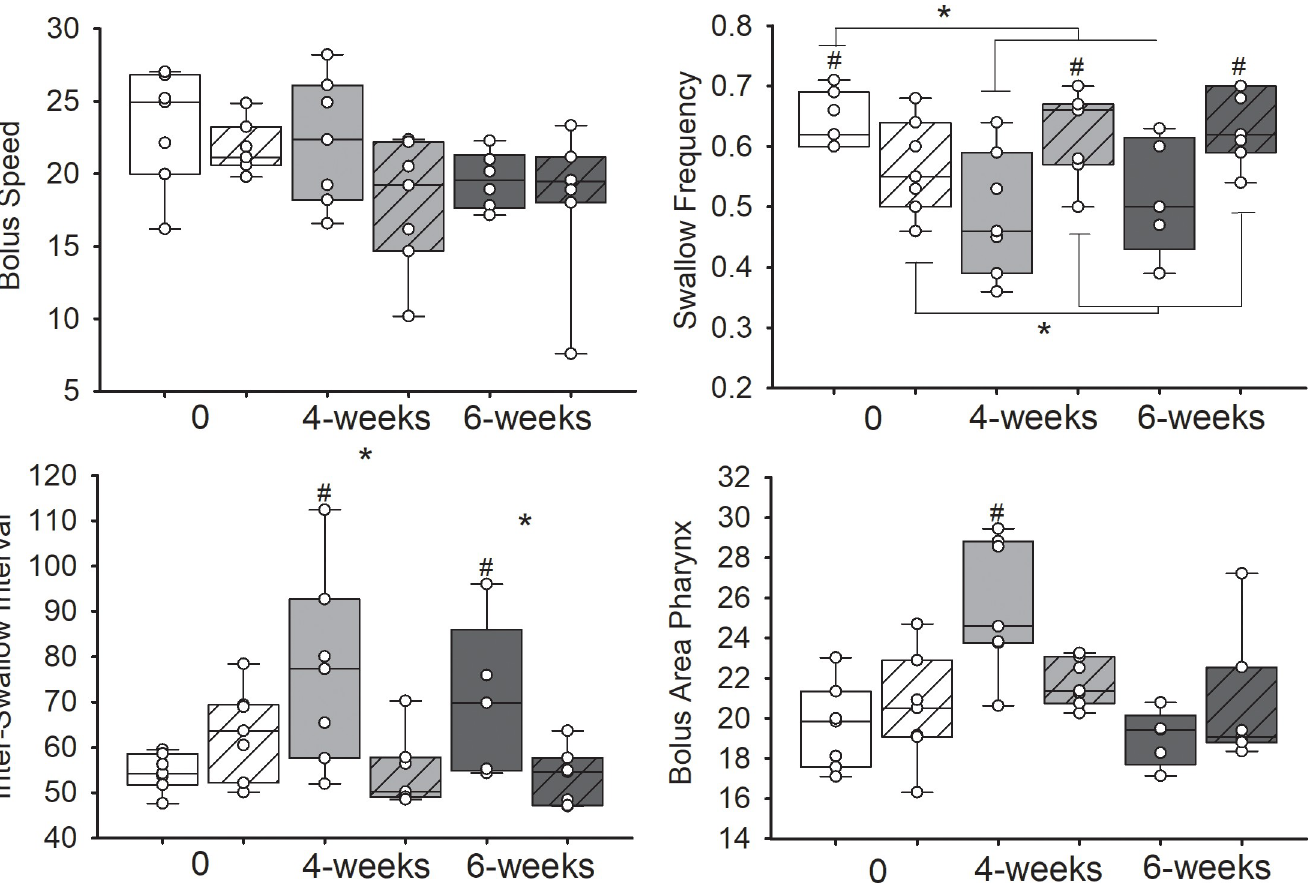
Fig 2. Changes in swallowing metrics taken from videofluoroscopic swallow studies. Radiated (no fill pattern) and sham (line pattern) treated animals were analyzed at baseline (0; white), at the end of treatment (4-weeks; grey), and after treatment (6-weeks; dark grey). Results demonstrate the mean and standard deviations for bolus speed through pharynx (mm/sec), swallow frequency (hz), inter-swallow interval (seconds), and bolus area in the pharynx (mm). The boundary of the box depicts the interquartile range and the line within the box marks the median. Whiskers above and below the box indicate the 90 th and 10 th percentiles. Each circle represents the mean value for a single animal. Statistically significant differences (p < 0.05) between groups are indicated by # and differences across time are designated by an